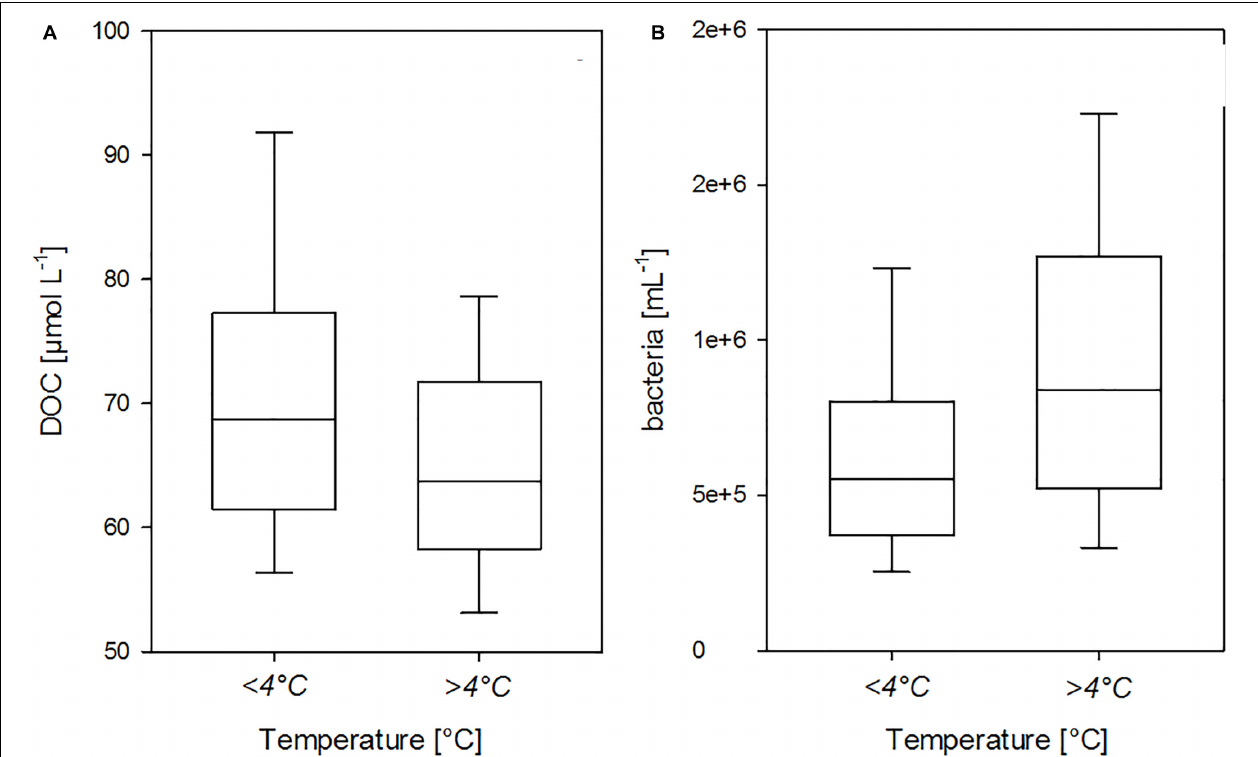
FIGURE 11 | Dependency of DOC concentration (A) and bacterial abundance on (B) seawater temperature in the upper 100 m water column of the HAUSGARTEN area. Box plots show 25–75th percentile of data within the box, error bars 10th and 90th percentile, and median values; DOC: n = 296 for < 4 ◦ C, n = 322 for > 4 ◦ C; bacteria: n = 254 for < 4 ◦ C, n = 272 for > 4 ◦